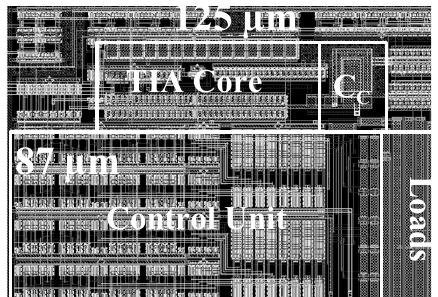
Figure 8. The top layout of the TIA and the area occupation of its sub-blocks.